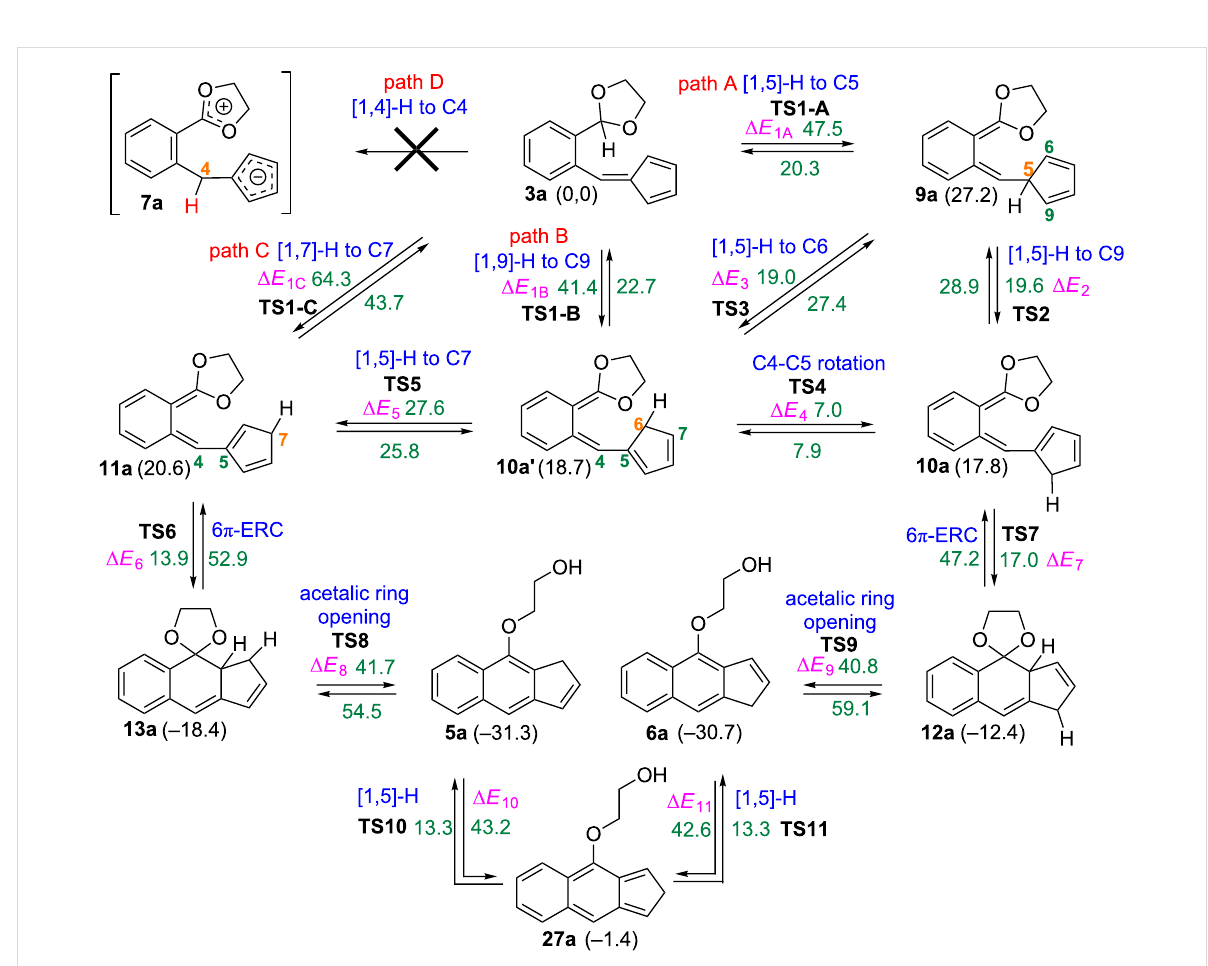
Scheme 9: Mechanistic paths for the conversion of fulvene 3a into the benz[ f ]indenes 5a and 6a showing the energy barriers of each step in kcal·mol − 1 as computed at the B3LYP/6-31+G** theoretical level (between parentheses the relative electronic energies of the minima in kcal·mol − 1 ).